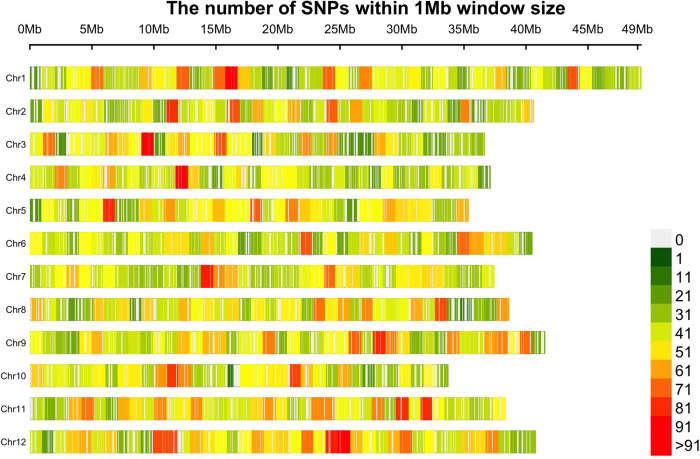
The distribution of 21,179 SNP markers in the twelve cranberry (Vaccinium macrocarpon Ait.) chromosomes. Marker counts are based on 1 Mb non-overlapping windows. Figure made with the R package CMplot.